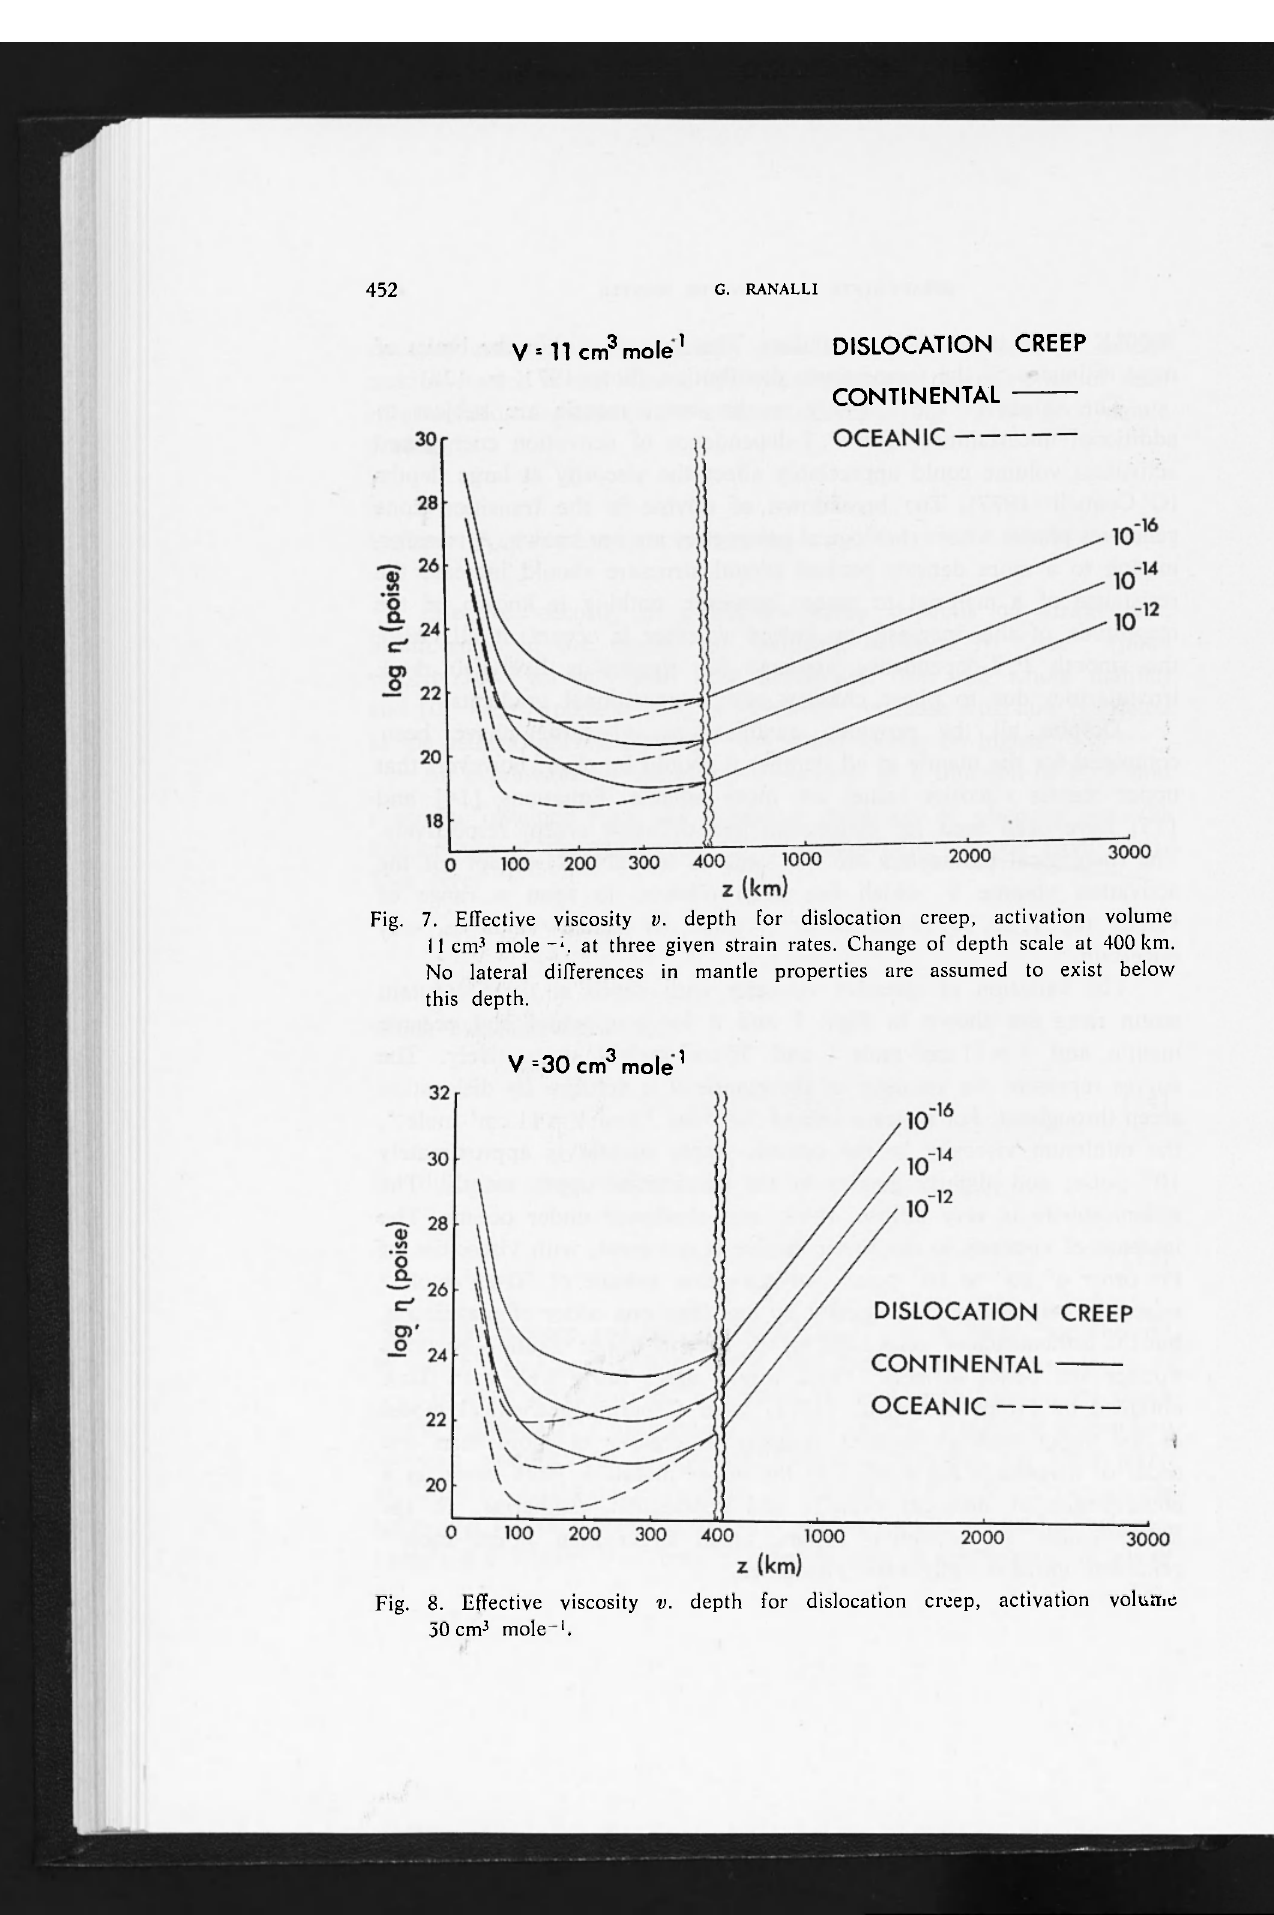
Fig. 8. Effective viscosity v. depth for dislocation creep, activation volume 50 cm 3